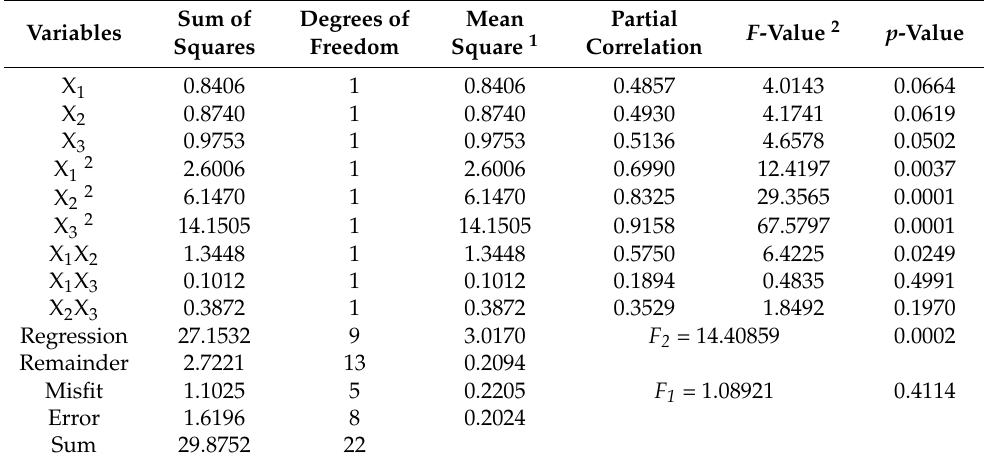
Table 5. Analysis of variance of a regression model based on in vitro dry matter digestibility (y 2 ). Sum of Degrees of Mean Partial Variables Squares Freedom Square 1